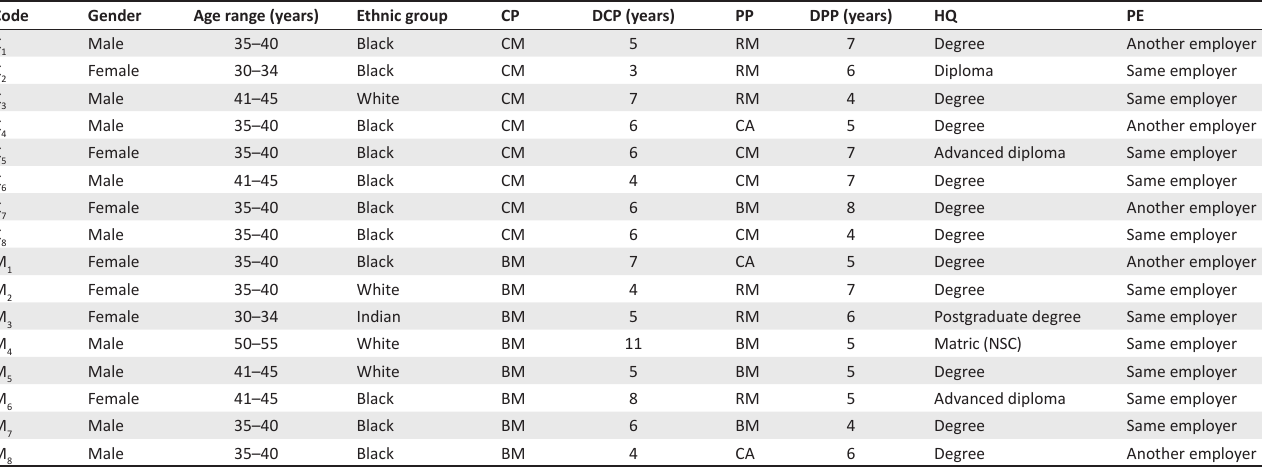
TABLE 1: Biographical data of participants.